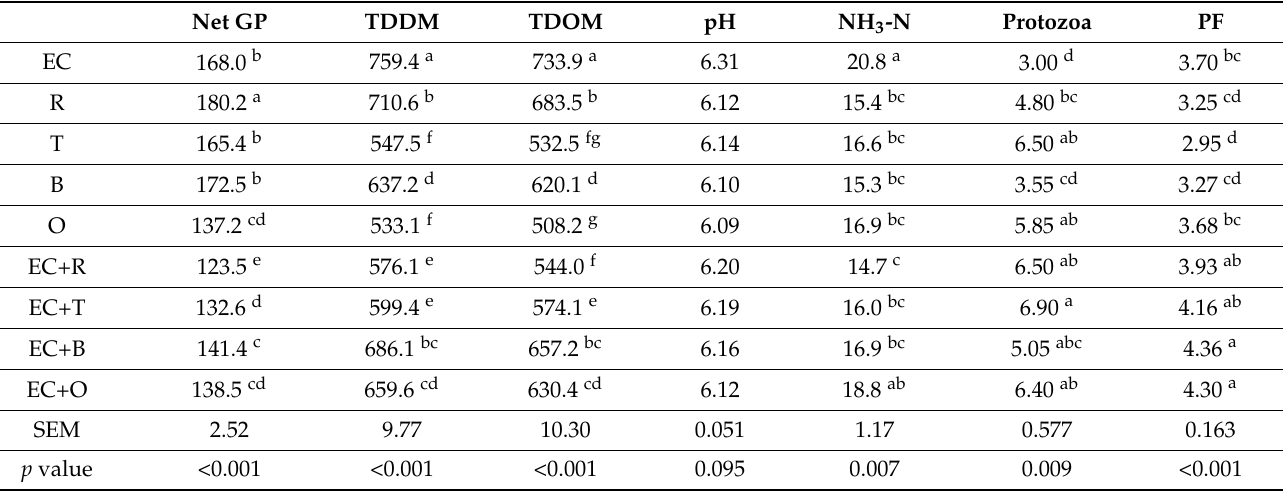
Table 4. Gas production, degradability, protozoal count, partitioning factor, and fermentation pH of intercropping of Egyptian